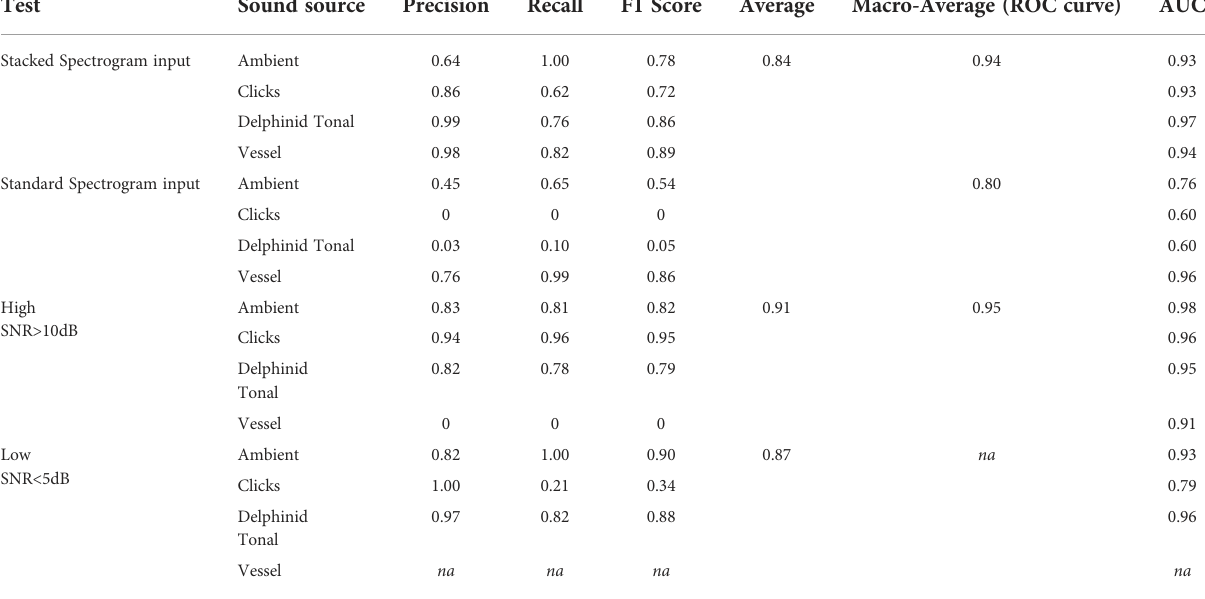
Test Sound source Precision Recall F1 Score Average Macro-Average (ROC curve) AUC